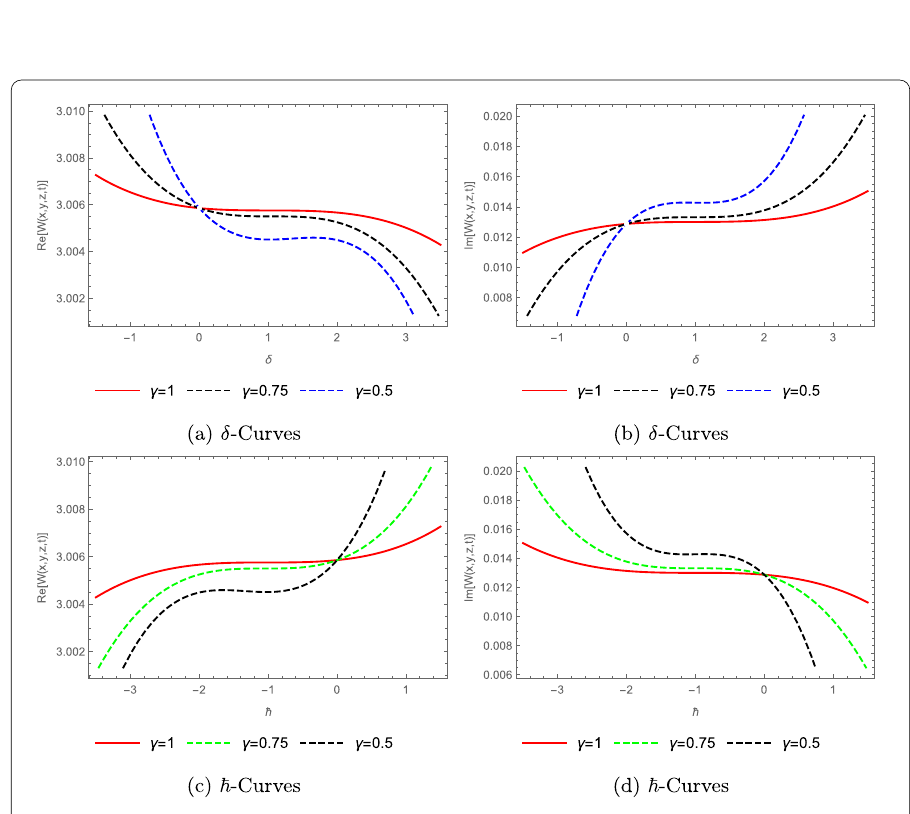
Figure 7 The curves plots of the real and imaginary parts of δ -HPTM and q-HATM solutions for Example 1